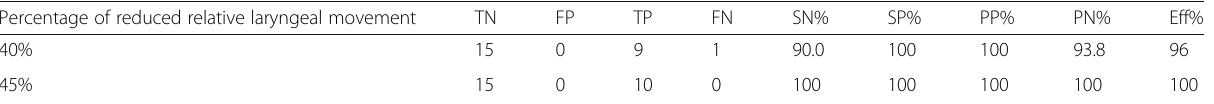
Table 4 The diagnostic validity of reduced laryngeal movement of ≤ 40% for diagnosing pharyngeal dysphagia and our study cut off value for diagnosing pharyngeal dysphagia Percentage of reduced relative laryngeal